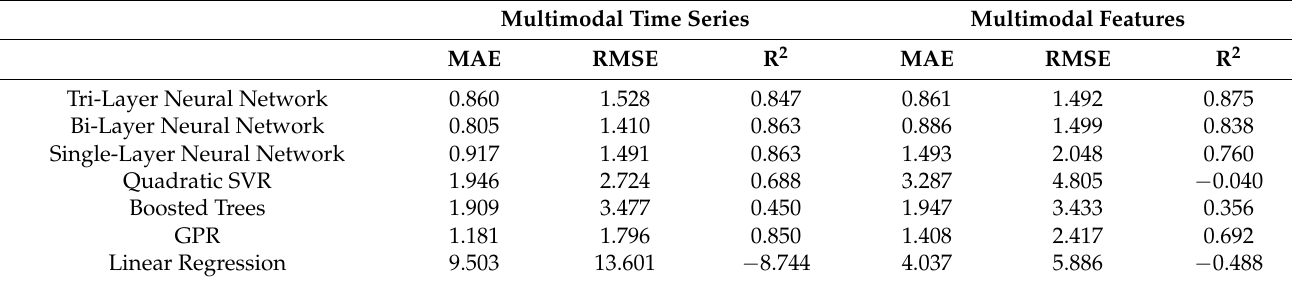
Table 1. ML prediction performance using multimodal time series and features for Vanillic